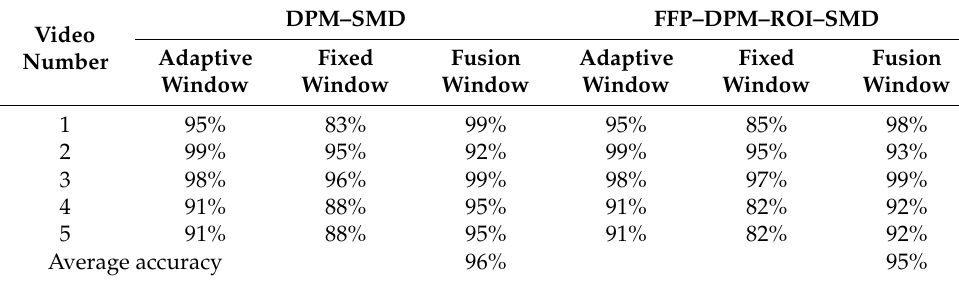
Figure 12. FFP–DPM–ROI–SMD algorithm inventory process. Table 3. Comparison of counting accuracies of different